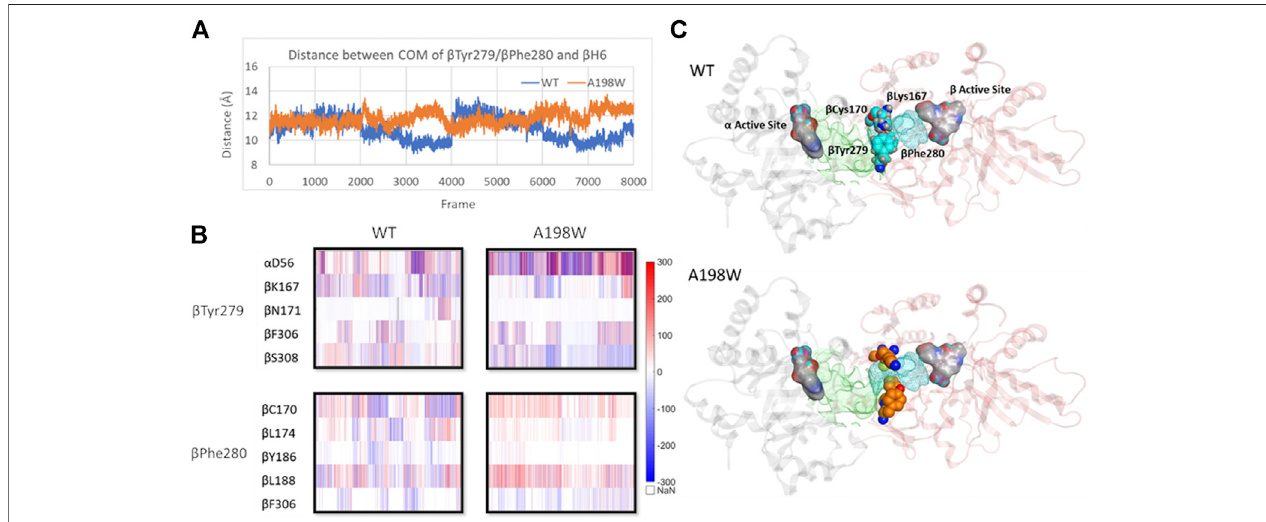
FIGURE 7 | Displacement of β H6 towards α TS leads to widening of indole channel which is further supported by weaker interactions between the channel lining residues β Tyr279 and β Phe280 with residues of β H6 in A198W. (A) Distance between center of mass of residues β Tyr279/ β Phe280 and β H6 lining the affected tunnel portion (B) Pairwise force distribution analysis indicates that interactions for residues β Tyr279 and β Phe280 have different trends in WT and A198W. (C) Interactions between β Tyr279and β Lys167positionthearomaticringwithintheindolechannel.Activesitesinbothsubunits(grey – α subunit,pink – β subunit)arerepresentedas atom colored surface. Indole path is shown in green surface and the affected portion of the channel is mapped in cyan. See also Supplementary Figure 12 .